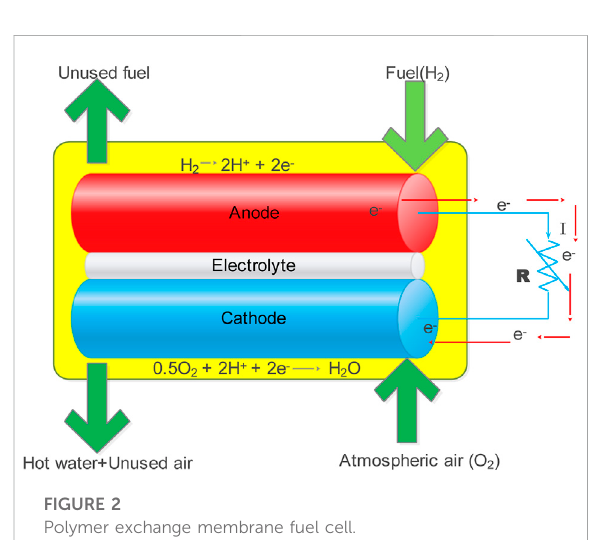
FIGURE 2 Polymer exchange membrane fuel